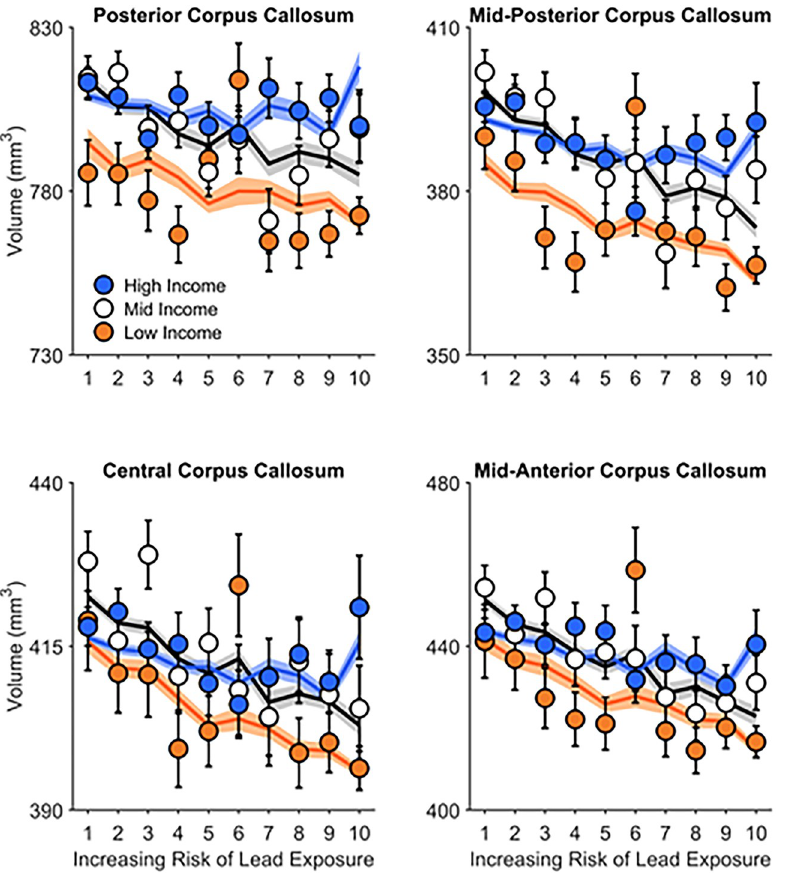
Fig 3. Posterior, mid-posterior, central, and mid-anterior corpus callosal volume significantly decreased with increasing risk of environmental lead exposure. These inverse associations were not significantly different between children from low-, mid-, and high-income families. Error bars represent ± 1 between-subjects standard error of the observed means. The solid lines represent means of the marginal fitted values of the model; the shaded area surrounding the solid lines represent ± 1 between-subjects standard error of those means. Age, sex, parental education, race, ethnicity, and intracranial volume were included as covariates in this analysis.